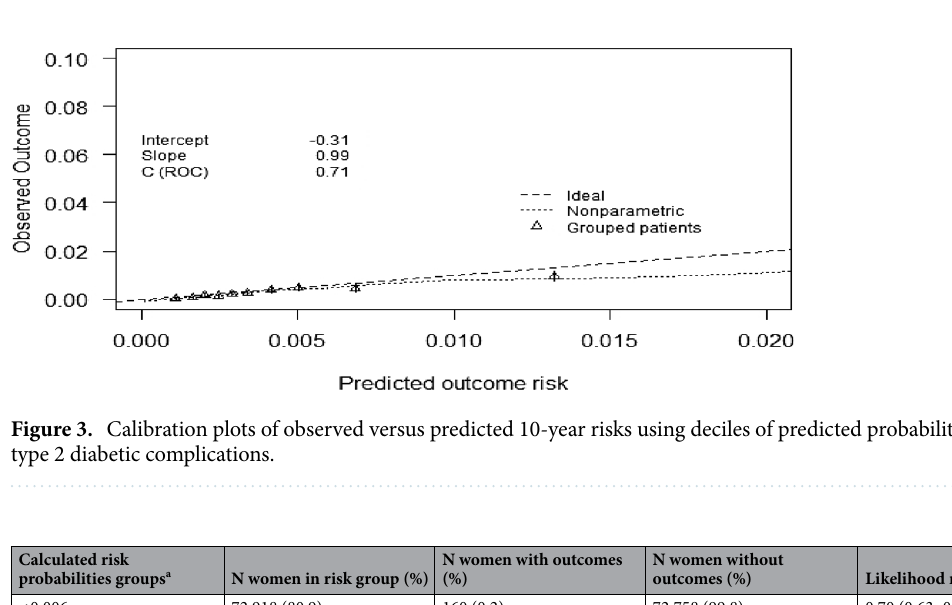
Figure 2. Area under the receiver operating characteristic curve [AUROC (95% confidence interval)] showing model discriminatory performance for 10-year prediction of type 2 diabetic complications.